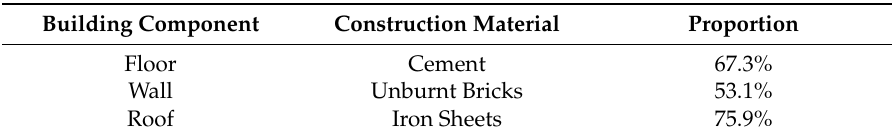
Table 1. Urban residential buildings’ construction materials by proportion of the urban residential building stock. Source: Adapted from NSO [40].